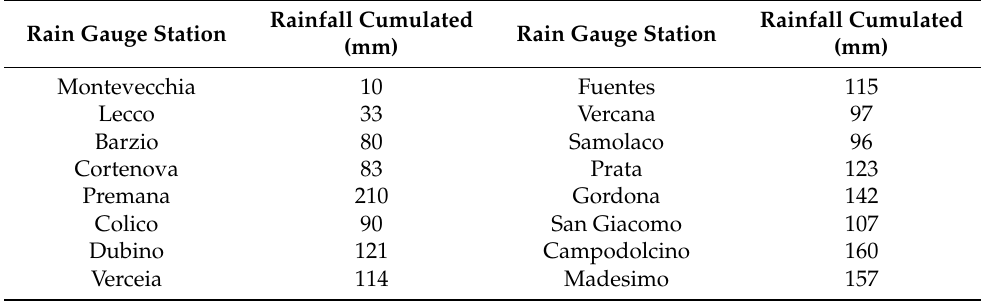
Table 1. The rain gauge amount recorded in the study area from 8 p.m. 11 June to 9 p.m. 12 June. Rain Gauge